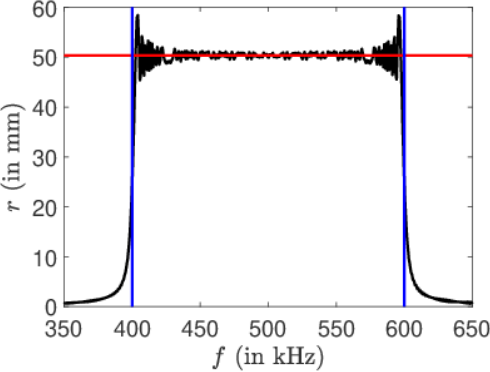
Figure A1. Excitation of an ensemble of ions by an adiabatic pulse: Evolution of the final radius as a function of the frequency. The parameters are set to t f = 10 ms, E 0 = 3.2 V/m and B 0 = 7 T. The red (light gray) solid line represents the stationary phase approximation. The vertical blue (dark gray) solid lines indicate the range of frequency of the